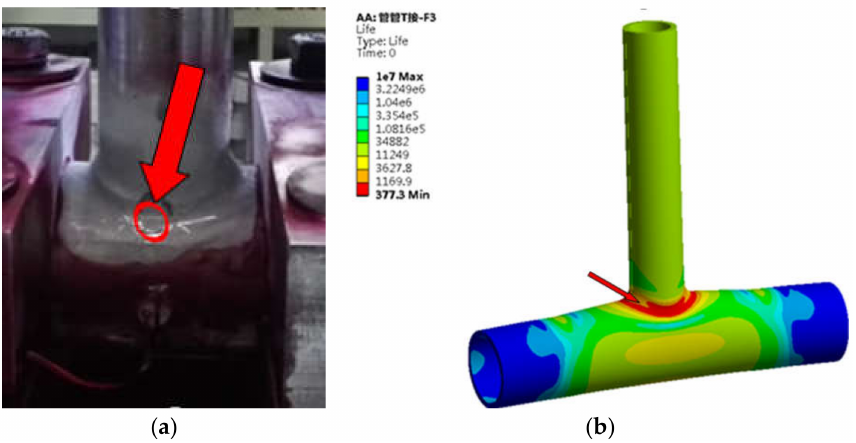
Figure 17. Comparison of fatigue damage in T-type tube joint ( a ) Test result ( b ) Finite element